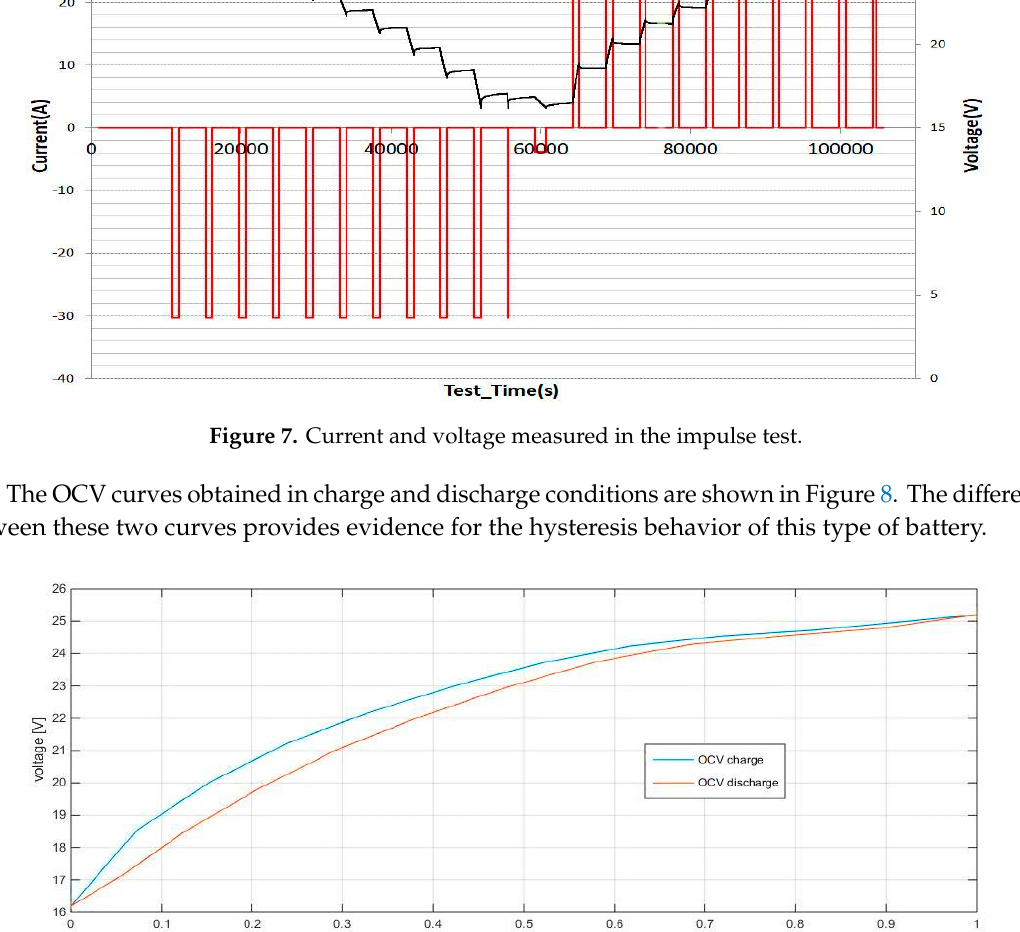
Figure 9. R 0 at different values of state of charge (SoC).